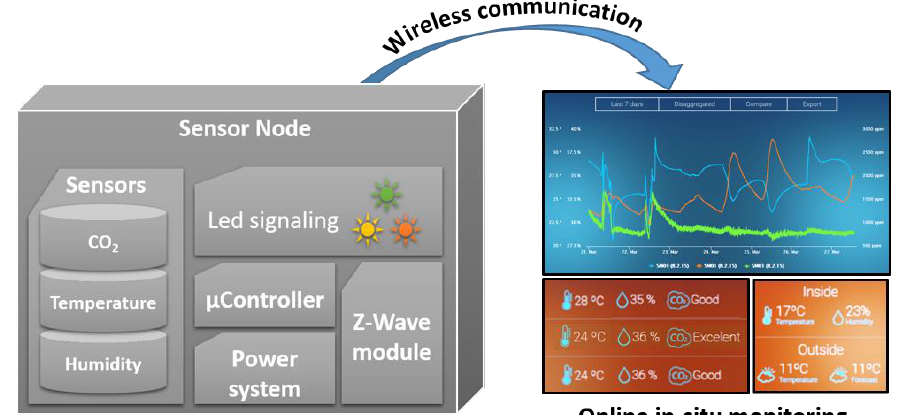
Figure 1. The concept of the individual sensor nodes is based on the use of micromachined sensor technology and internet connectivity in order establish a wireless network for online, in-situ indoor environmental monitoring. The CO 2 concentration is determined by listening to its concentration via the photoacoustic effect. Both temperature and humidity are determined using state-of-the-art microtechnology.